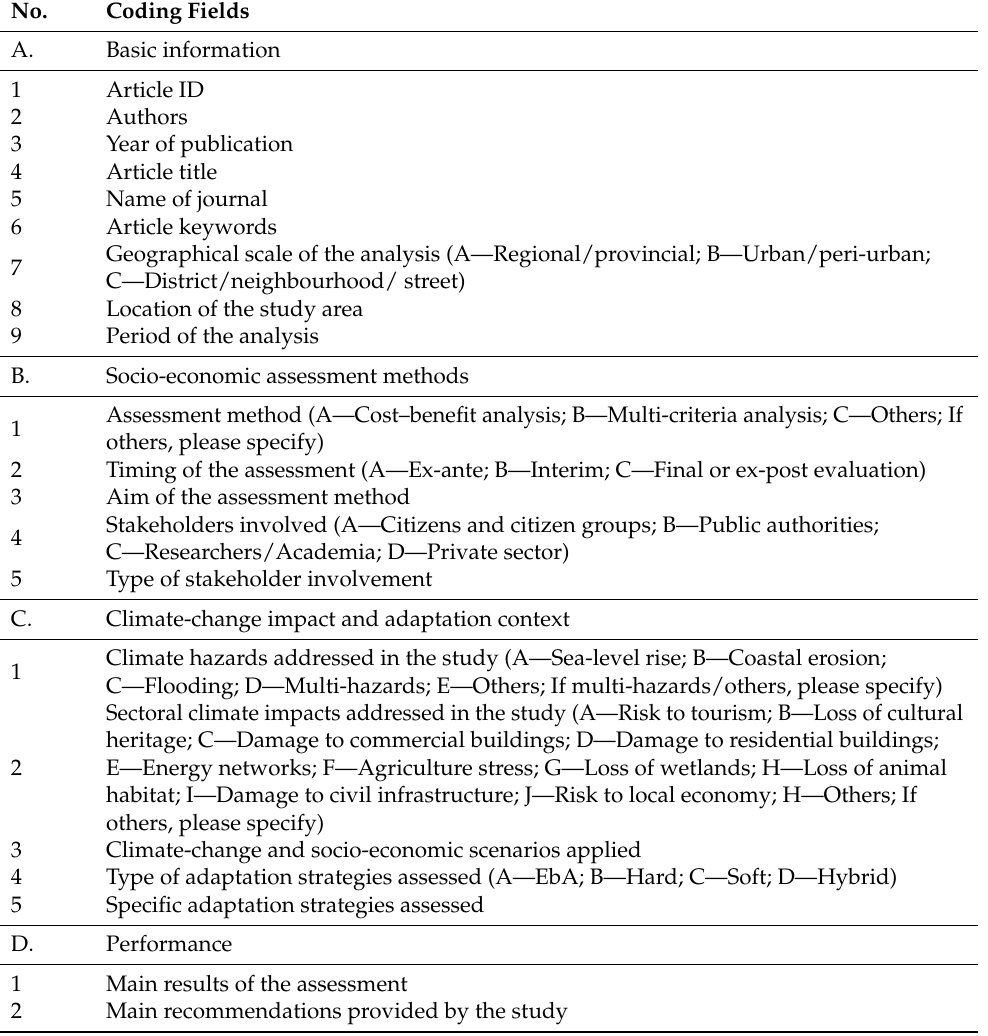
Table 2. Variables analyzed in the full-text